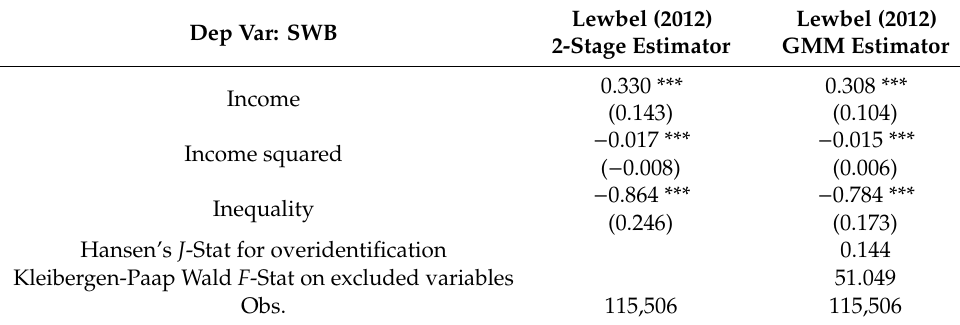
Table 7. Results from heteroskedasticity based